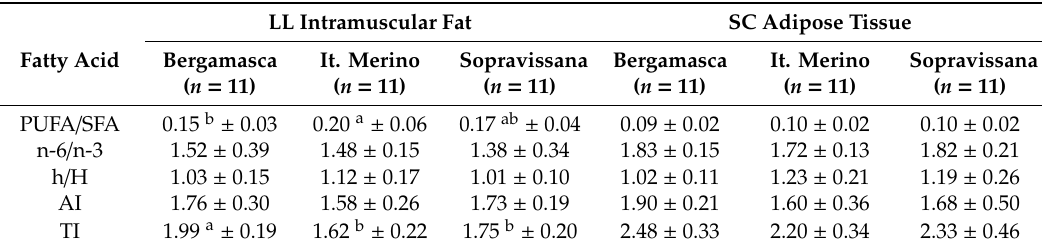
Values with different letters in the same row are significantly different ( p < 0.05). SFA = Σ (C10:0, C11:0, C12:0, C13:0, C14:0, C15:0, C16:0, C17:0, C18:0, C20:0, C21:0); MUFA = Σ (C14:1, C16:1 n-7, C17:1, Σ 18:1c); PUFA = (C18:2 n-6,